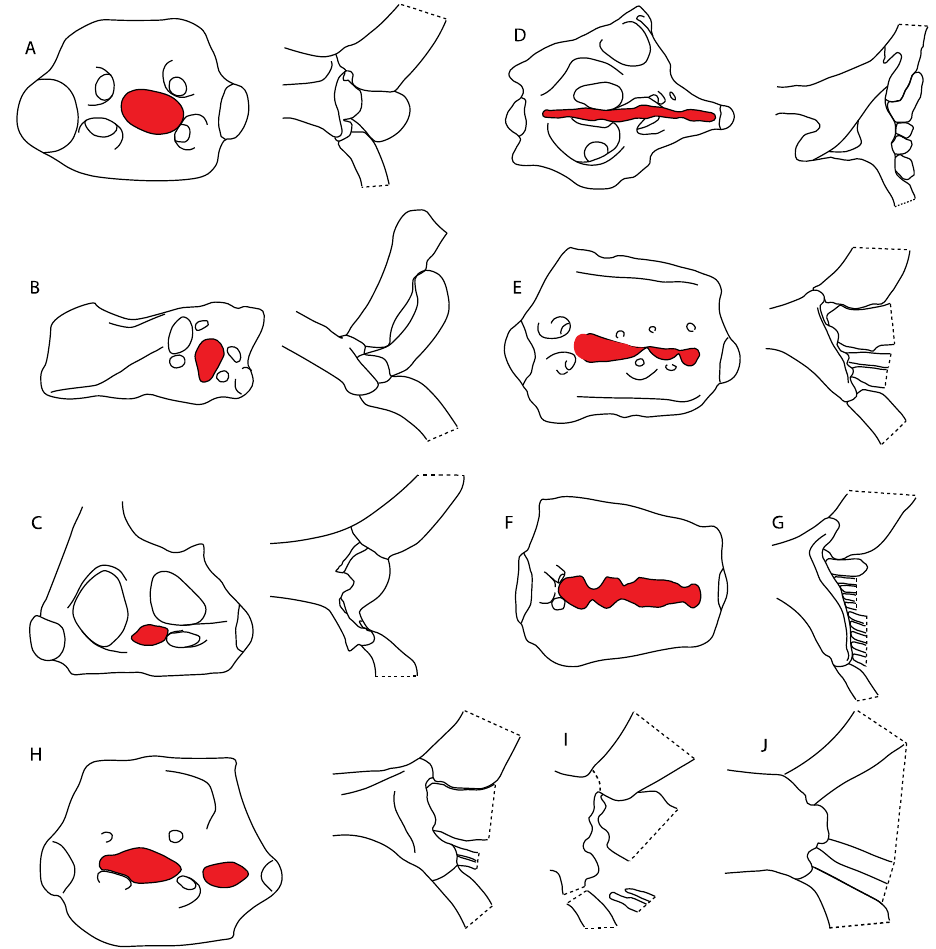
Figure 38. Interpretative drawings of scapulacoracoid in lateral view and dorsal view of the scapu- lacoracoid and pectoral elements. State (0): ( A ) Rhinobatos productus (CNPE-IBUNAM 17829); ( B ) Narke japonica. (HUMZ 94970) redrawn and modified from Nishida Text-Figure 32E in [82]; ( C ) Raja clavata (BRC–Raja). State (2): ( D ) Myliobatis goodei (HUMZ 91851) redrawn and modified from Nishida Text-Figure 31C [82]; ( E ) Zapteryx exasperata (CNPE-IBUNAM 20528); ( F ) Zanobatus schoen- leinii (UF 176858, https://sharksrays.org/ (accessed on 25 March 2020)); ( G ) Zanobatus sp. (MNHN 1989. 12. 91) redrawn and modified from Brito and Seret Text-Figure 5b in [106]. State (1): ( H ) Aptychotrema vincentiana (CSIRO 101, https://sharksrays.org/ (accessed on 25 March 2020)); ( I ) † Stahl- raja sertanensis (UERJ-PMB P 400); ( J ) † Tlalocbatos applegatei (IGM 5853). Mesocondyle marked in red color.